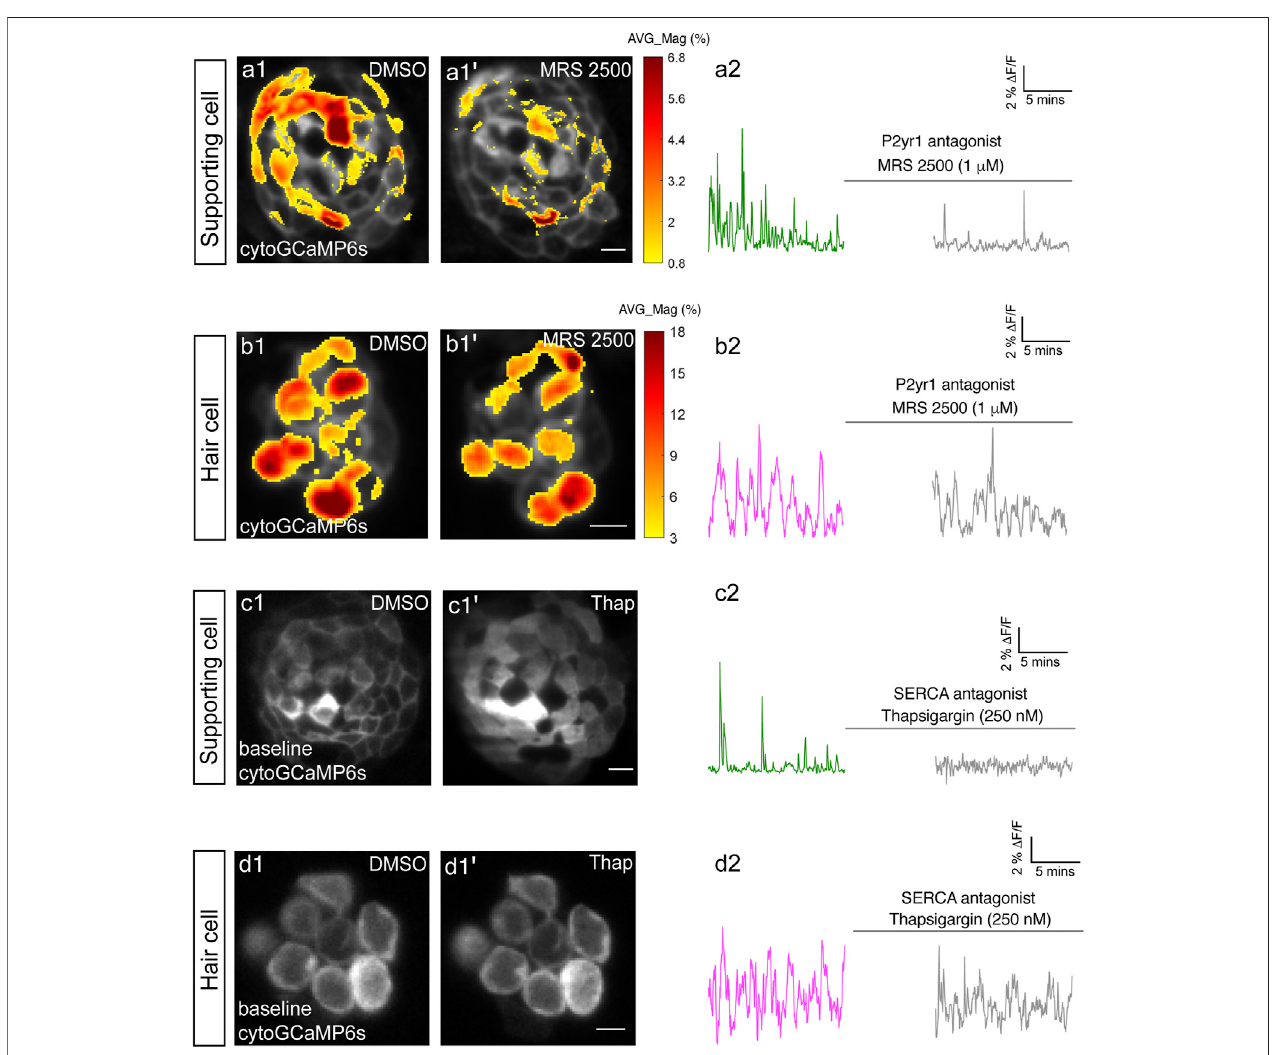
FIGURE 2 | P2yr1 signaling is required for spontaneous activity in supporting cells but not immature hair cells. The spatial patterns of the mean spontaneous calcium activities of the supporting cells (A1 – A1 9 ) or hair cells (B1 – B1 9 ) in DMSO and after 15 min of treatment with 1 µM MRS2500. Measurements were performed in immature neuromasts at day 3. The Δ F/F GCaMP6s signals were averaged over each 900 s interval (pre- and post-treatment) and then colorized according to the heat map and superimposed onto a baseline image. The corresponding temporal curves of the mean signal magnitude across the whole neuromast in supporting cells (A2) and in hair cells (B2) in DMSO and after 15 min of treatment with 1 µM MRS2500. The cytosolic baseline calcium in the supporting cells (C1 – C1 9 ) and hair cells (D1 – D1 9 ) in DMSO and after 15 min of treatment with 250 nM Thapsigargin. Measurements were performed in immature neuromasts at day 3. The corresponding temporal curves of the mean signal magnitude across the whole neuromast in supporting cells (C2) and in hair cells (D2) in DMSO and after 15 min of treatment with 250 nM Thapsigargin. Scale bar = 5 μ m.